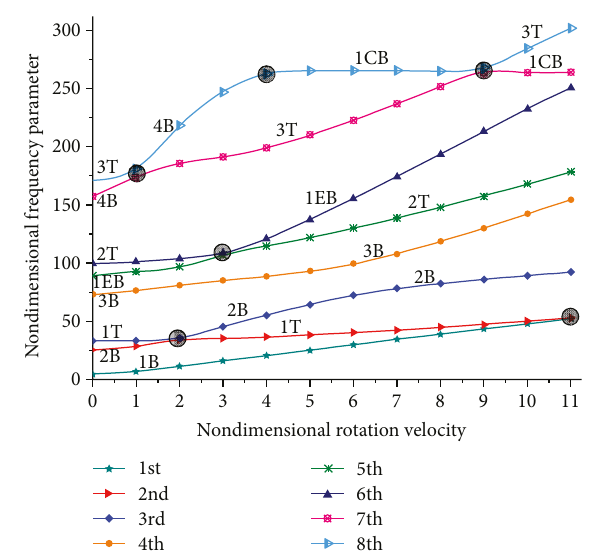
Figure 12: A Campbell diagram of the FG sandwich blade ( l = 3 , = 1/2 , θ = 30 ° , r = 1 , and φ = 45 ° ). h = 20 , n = 2 , h l